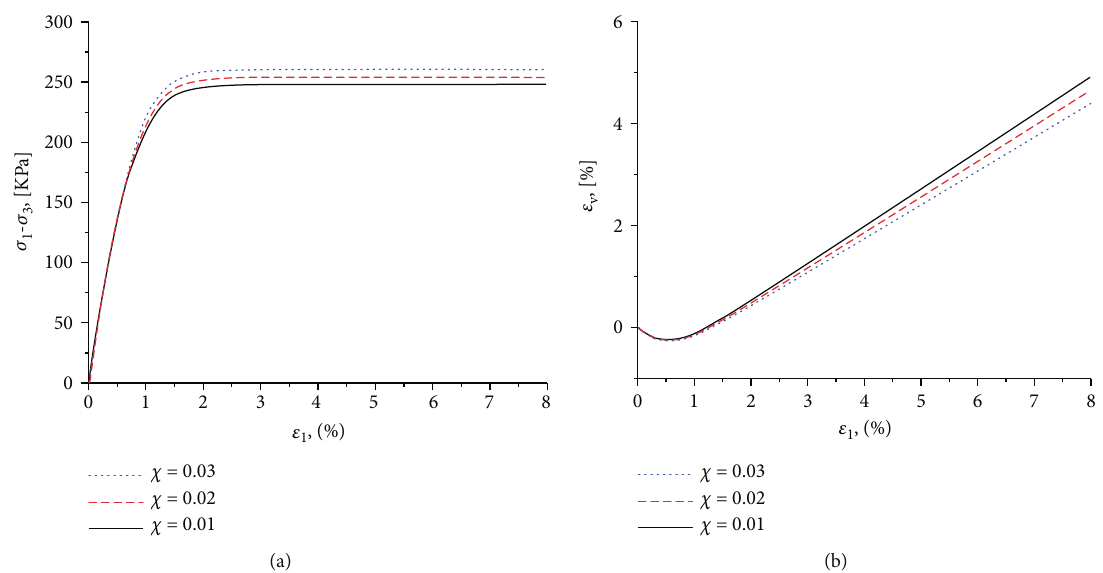
Figure 5: Simulation of triaxial tests for various material constant: (a) deviatoric stress vs. axial strain; (b) volumetric strain vs. axial